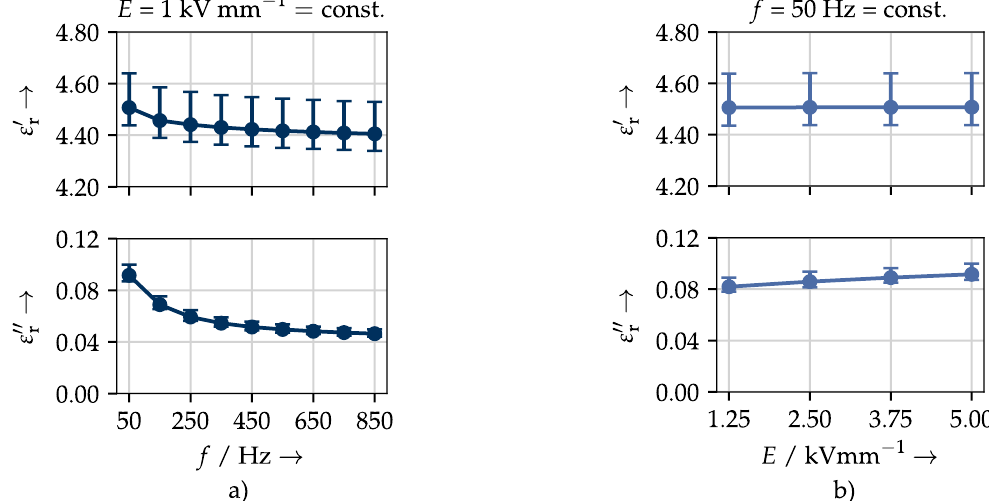
Figure 6. Real and imaginary part of the complex relative permittivity of epoxy polymer as a function of ( a ) frequency and ( b ) electric field strength, the mean and range of three test